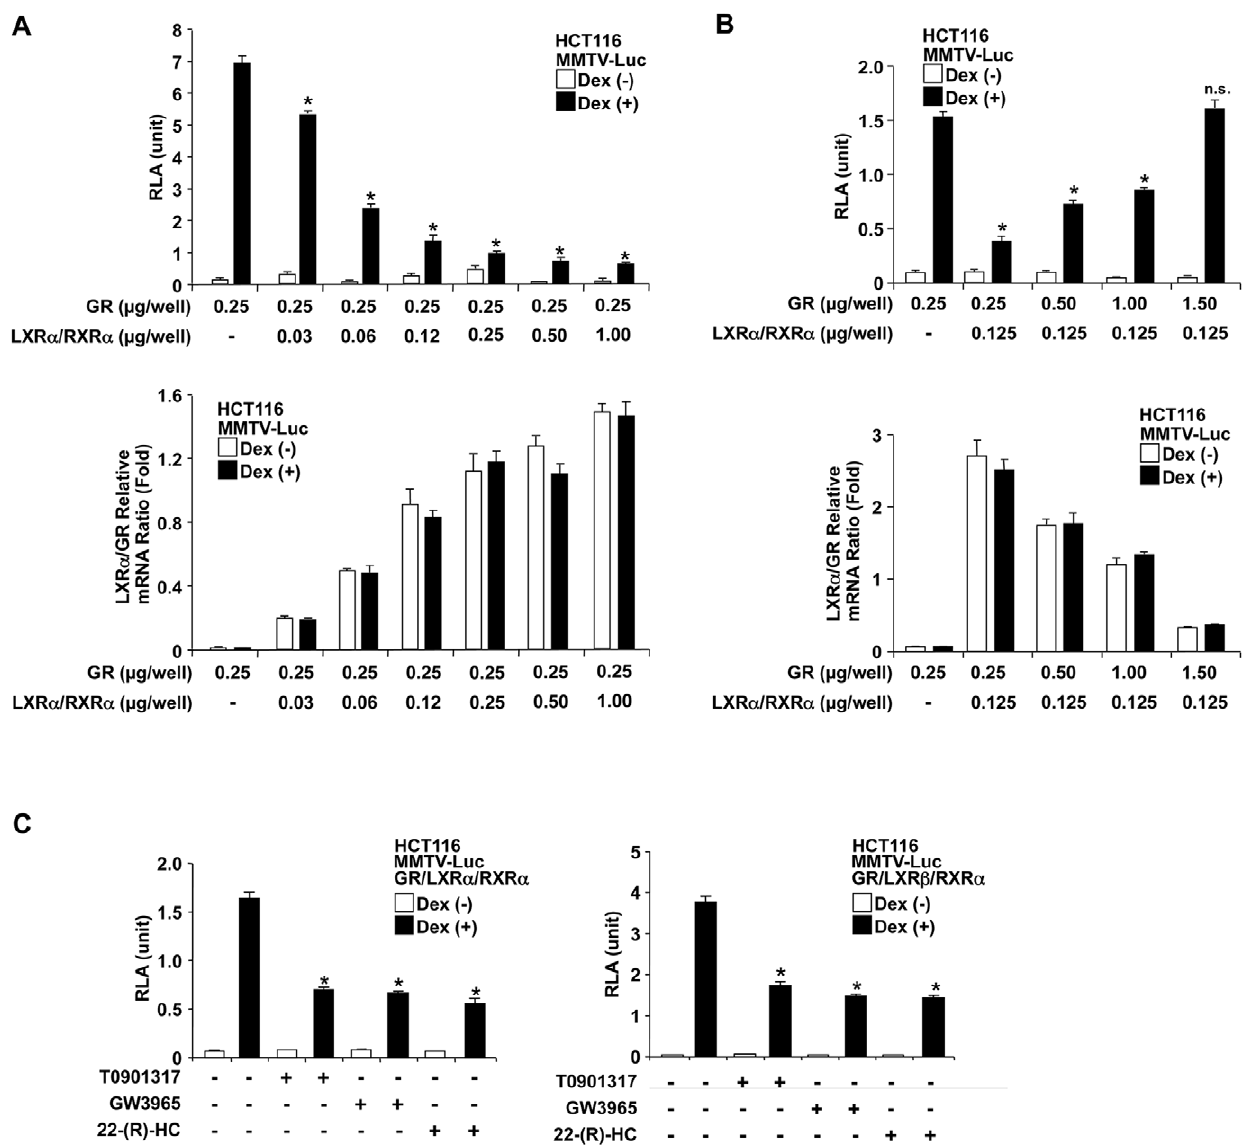
Figure 1. LXRs repress GR-induced transcriptional activity in HCT116 cells. A. Over-expression of LXRs strongly suppresses dexamethasone- stimulated transcriptional activity of the MMTV promoter in HCT116 cells. HCT116 cells were transfected with pRShGR a together with pMMTV-Luc and pGL4.73[ hRluc /SV40], and increasing amounts of pCMX-hLXR a and pCMX-hRXR a (0.03–1 m g), and were incubated in the presence or absence of 10 2 6 M dexamethasone. Upper panel: Bars represent mean 6 S.E. values of the firefly luciferase activity normalized for the renilla luciferase activity in the presence or absence of 10 2 6 M dexamethasone. *: p , 0.01, n.s.: not significant, compared to the condition treated with dexamethasone in the absence of LXR a /RXR a . Lower panel: Total RNA from transfected HCT116 cells was harvested and relative mRNA expression of LXR a and GR were measured with the SYBR-Green real-time PCR. Bars represent mean 6 S.E. values of the relative ratios of LXR a mRNA vs. GR mRNA using RPLP0 as an internal control. Dex: dexamethasone, RLA: relative luciferase activity. B. Over-expression of GR reverses the negative effect of LXR a /RXR a on dexamethasone-stimulated transcriptional activity of the MMTV promoter. HCT116 cells were transfected with increasing amounts of pRShGR a (0.25– 1.5 m g) together with pMMTV-Luc, pGL4.73[ hRluc /SV40], pCMX-hLXR a and pCMX-hRXR a , and were incubated in the presence or absence of 10 2 6 M dexamethasone. Upper panel: Bars represent mean 6 S.E. values of the firefly luciferase activity normalized for the renilla luciferase activity in the presence or absence of 10 2 6 M dexamethasone. *: p , 0.01, n.s.: not significant, compared to the condition treated with dexamethasone in the absence of LXR a /RXR a . Lower panel: Total RNA from transfected HCT116 cells was harvested and relative mRNA expression of LXR a and GR were measured with the SYBR-Green real-time PCR. Bars represent mean 6 S.E. values of the relative ratios of LXR a vs. GR mRNA using RPLP0 as an internal control. Dex: dexamethasone, RLA: relative luciferase activity. C. Over-expression of LXR a ( left panel ) or LXR b ( right panel ) in the presence of indicated LXR ligand suppresses dexamethasone-stimulated GR transcriptional activity on the MMTV promoter. HCT116 cells were transfected with pRShGR a , pMMTV-Luc and pGL4.73[ hRluc /SV40] together with pCMX-hLXR a or -mLXR b and pCMX-mRXR a , and were incubated in the presence or absence of 10 2 6 M dexamethasone and/or indicated LXR ligands. Bars represent mean 6 S.E. values of the firefly luciferase activity normalized for the renilla luciferase activity. *: p , 0.01 compared to the condition treated with dexamethasone in the absence of LXR ligand. Dex: dexamethasone, RLA: relative luciferase activity, 22-R-HC: 22-R-hydroxycholesterol.